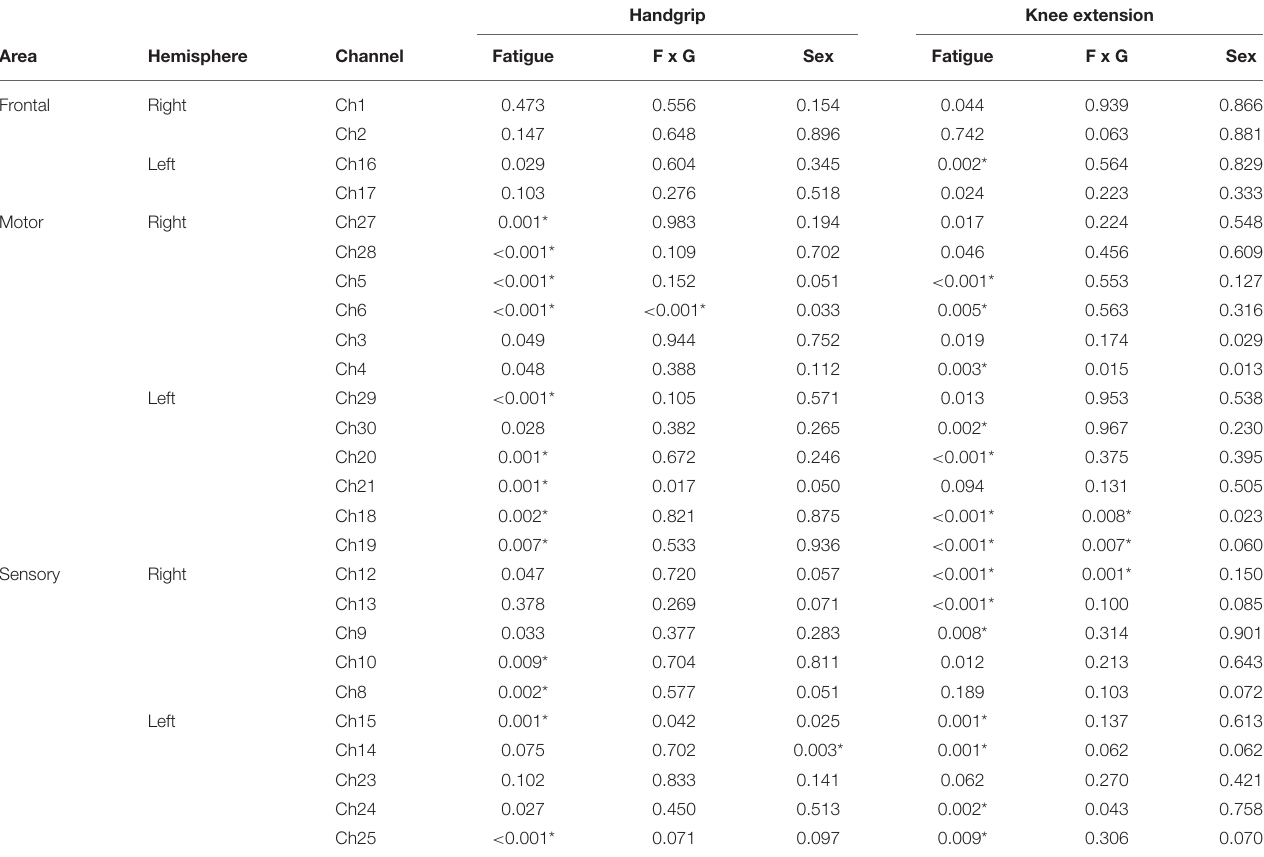
TABLE 3 | Observed p-values for each channel of fNIRS measurements.